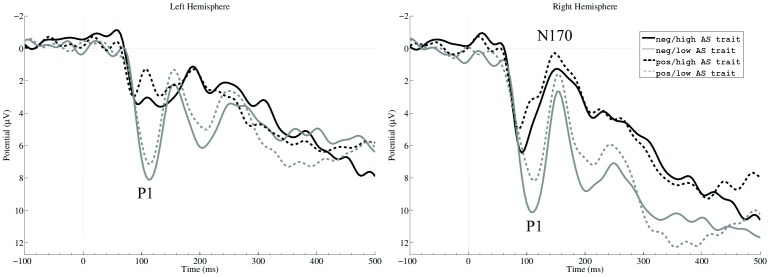
Grand average waveforms.Grand averages of the feedback presentation of low antisocial trait (low AS trait; grey) and high antisocial trait (high AS trait; black) individuals depicted at left (averaged mean amplitudes of L23 and L24) and right (averaged mean amplitudes of R26 and R27) electrode locations. The dotted line at time 0 indicates stimulus onset, negative is drawn upwards per convention.